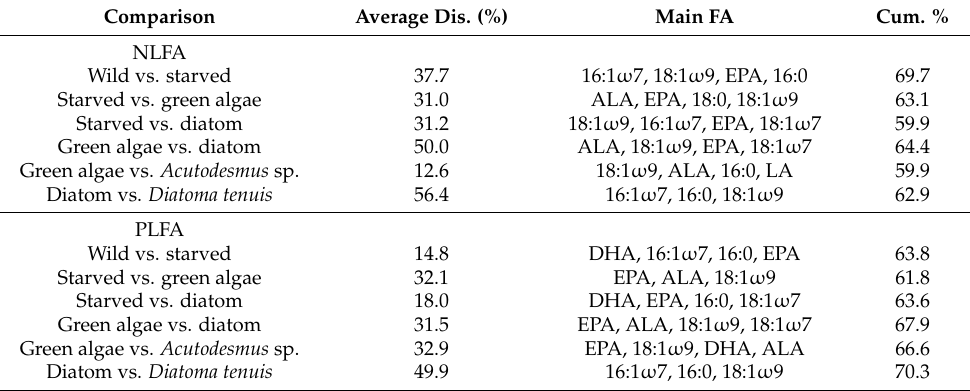
Table 2. Average dissimilarities (%) of pairwise comparison of fatty acid profiles of wild, starved (day 0), green algae and diatom-fed amphipods. Additionally, a pairwise comparison was made between amphipods fed with green algae or diatoms ( Acutodesmus sp. or D. tenuis ). Fatty acids accounted for most (>60%) of the dissimilarities between groups. Cumulative percentage shows the percentage of variance explained by these main FA.